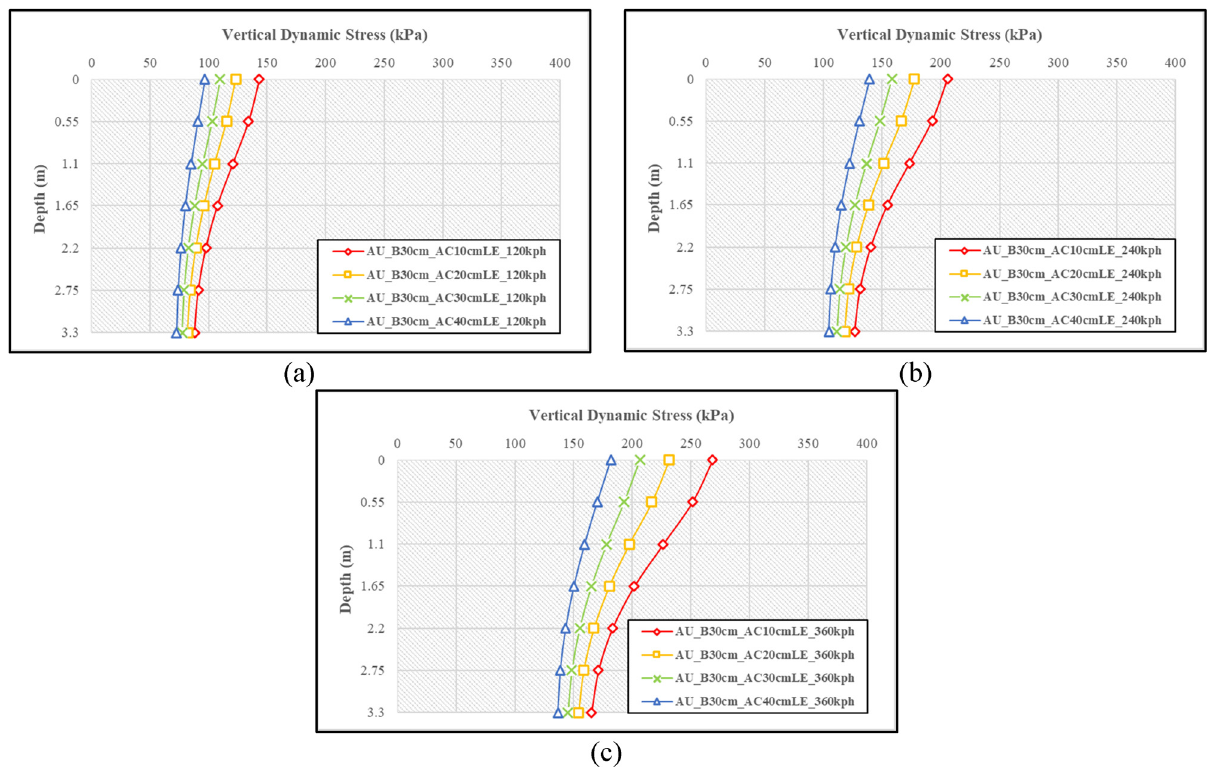
Figure 8: Vertical compressive stress curve in subgrade layer of asphaltic underlayment track with 10, 20, 30, and 40 cm of AC layer: ( a ) 120 kph, ( b ) 240 kph, and ( c ) 360